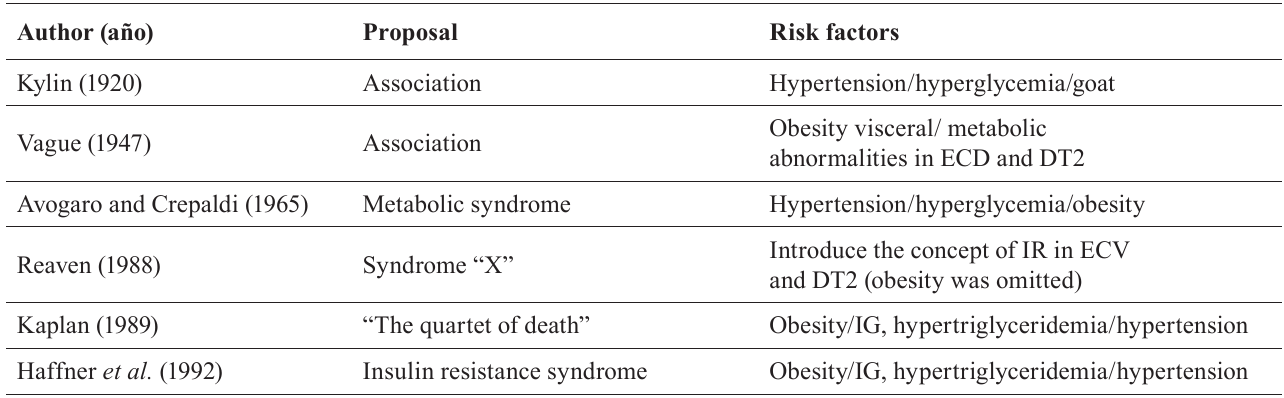
TABLE I - M etabolic syndrome: Origen of the concept (Crepaldi, Maggi, 2006; Kaur, 2014)